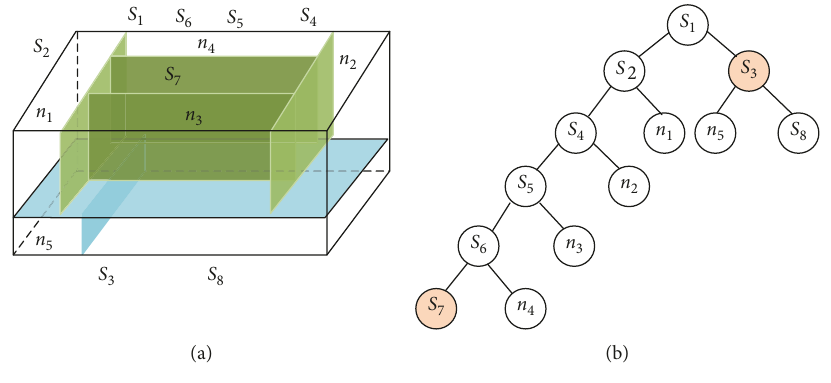
Figure 2: The kd-tree construction: (a) 3D. (b)